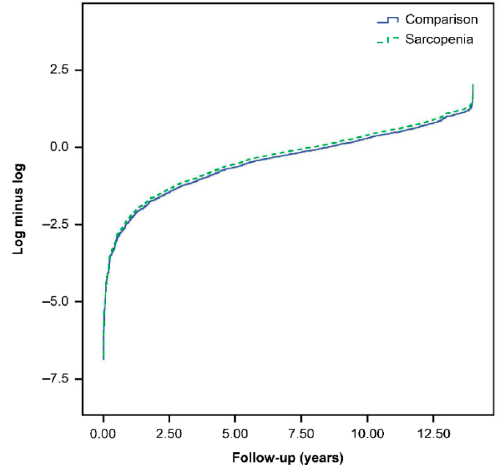
Figure 2. Plots of the log [ − log (survival function)] versus the log of survival time for the comparison cohort and sarcopenia cohort.